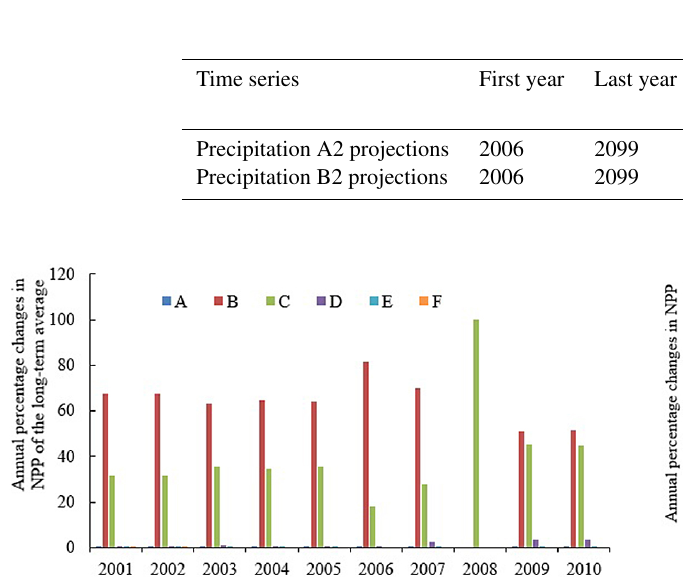
Figure 5. Percentage of changes in forest area or the deviation from the long-term average of NPP.